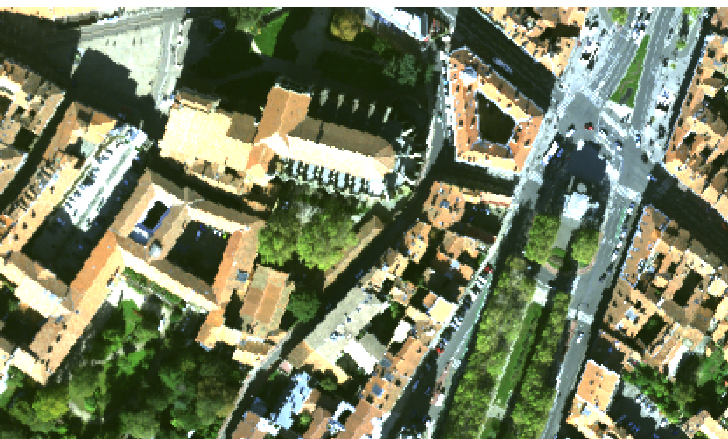
Figure 2. Sub-image selected for the intra-class variability